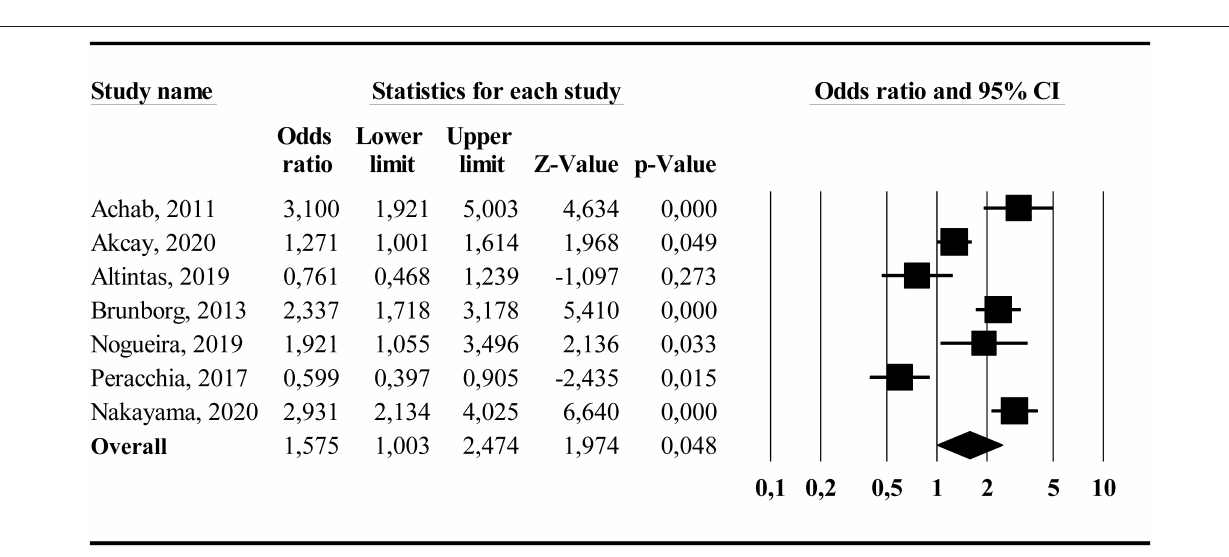
sleep questionnaires ( k = 9) showed a significant difference between groups ( Q bet = 7.20, df = 1, p < 0.01), where the multi- item sleep questionnaire subgroup yielded a higher overall effect size ( OR = 3.47, 95% CI [2.51, 4.81]) compared to the single-item sleep measure subgroup ( OR = 1.77, 95% CI [1.23, 2.65]).